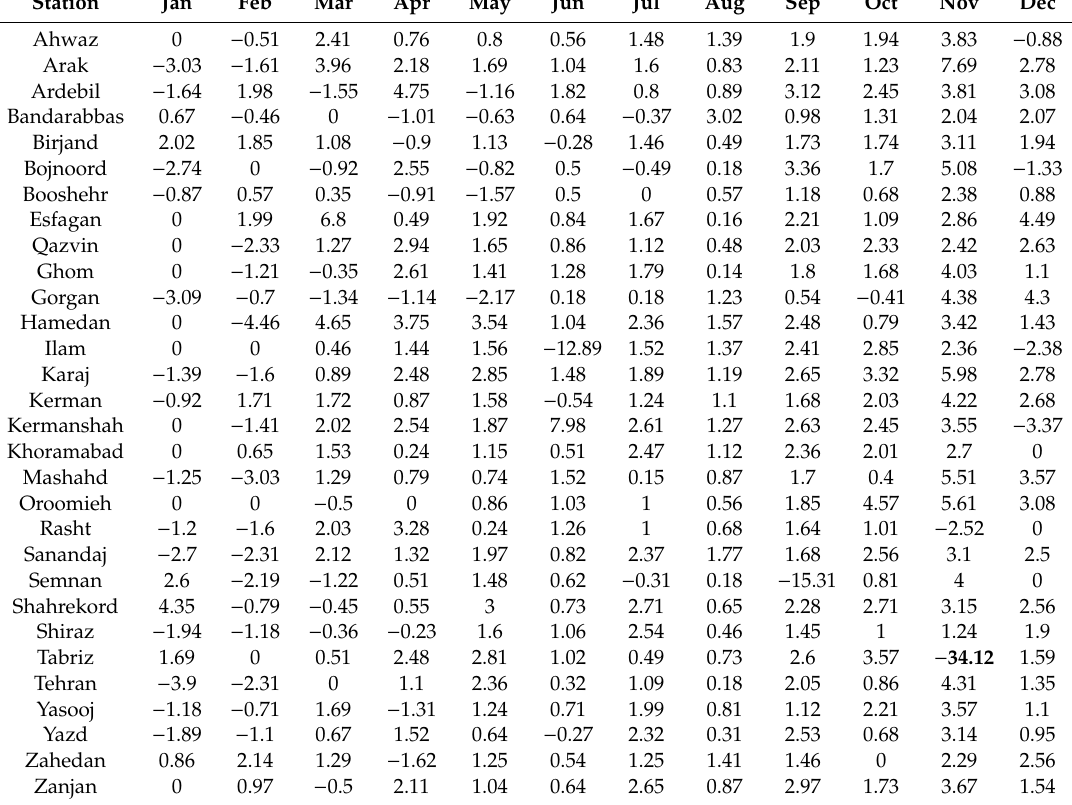
Table 2. Change percentages of the ET 0 predicted for the period from 2011 to 2045 under the A2 scenario.